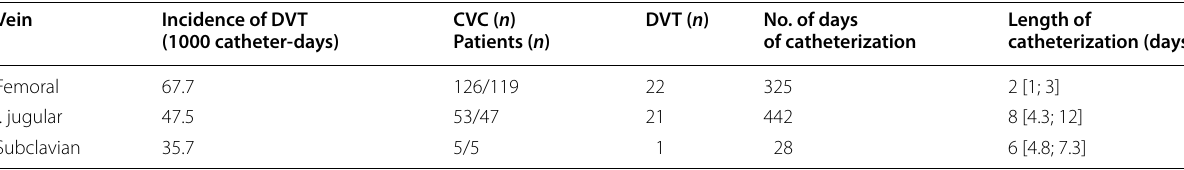
Table 2 Relation between central venous catheter characteristics and